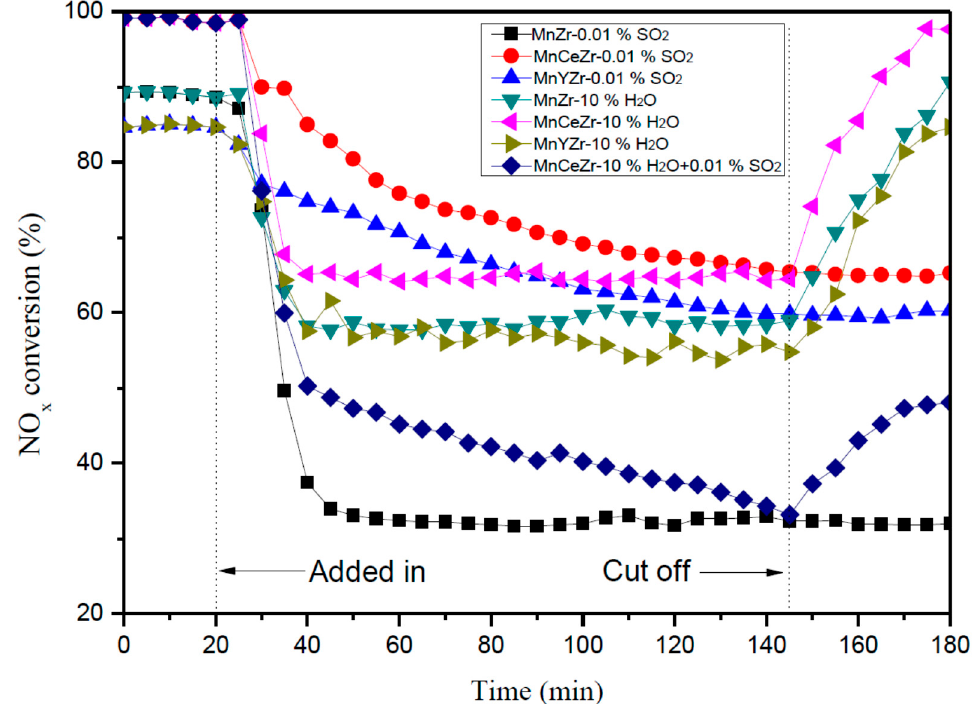
Figure 2. Effect with/without SO 2 or H 2 O on the SCR activity of catalyst reaction conditions: 0.1% NO; 0.1% NH 3 ; 5% O 2 ; 10% H 2 O (when added); 0.01% SO 2 (when added); and 200 °C, Ar balance.